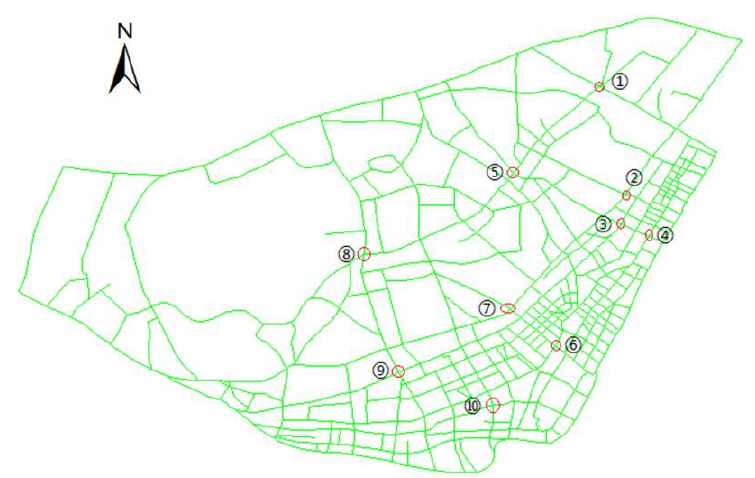
Figure 19. Distribution of 10 pairs of nodes with the same name. Figure 19 . Distribution of 10 pairs of nodes with the same name.